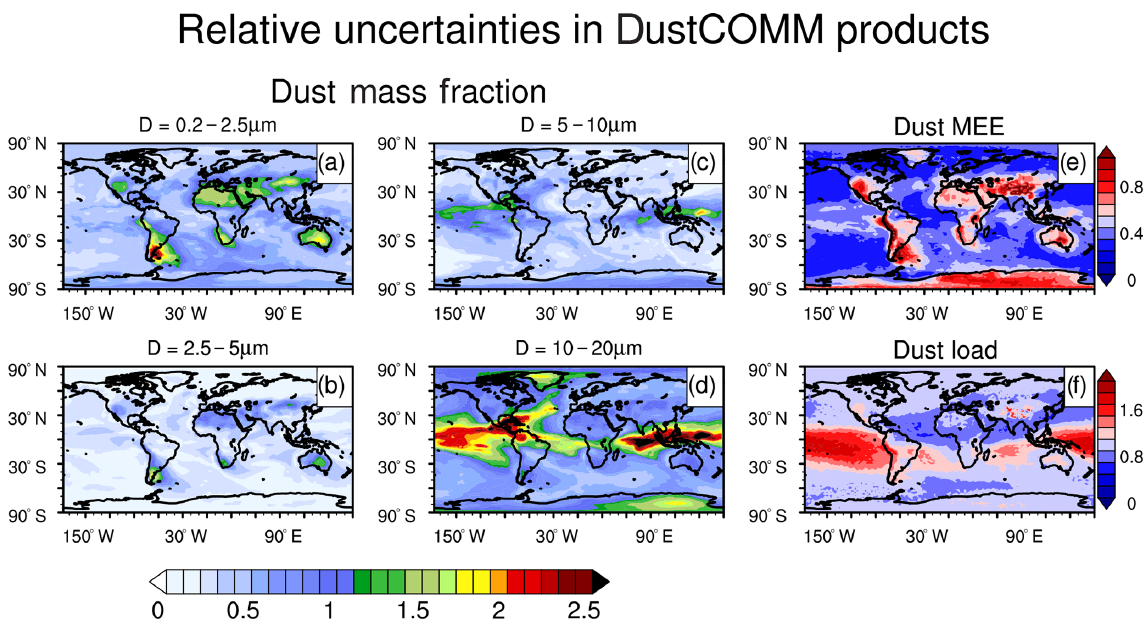
Figure 11. Spatial distributions of DustCOMM relative uncertainties for (a–d) the dust mass fraction in the diameter ranges of 2–25, 25–5, 5–10, and 10–20µm; (e) the dust MEE; and (f) dust load. The relative uncertainties are calculated as the ratio of the uncertainty characterizing 68% of the distribution of each variable, divided by the mean